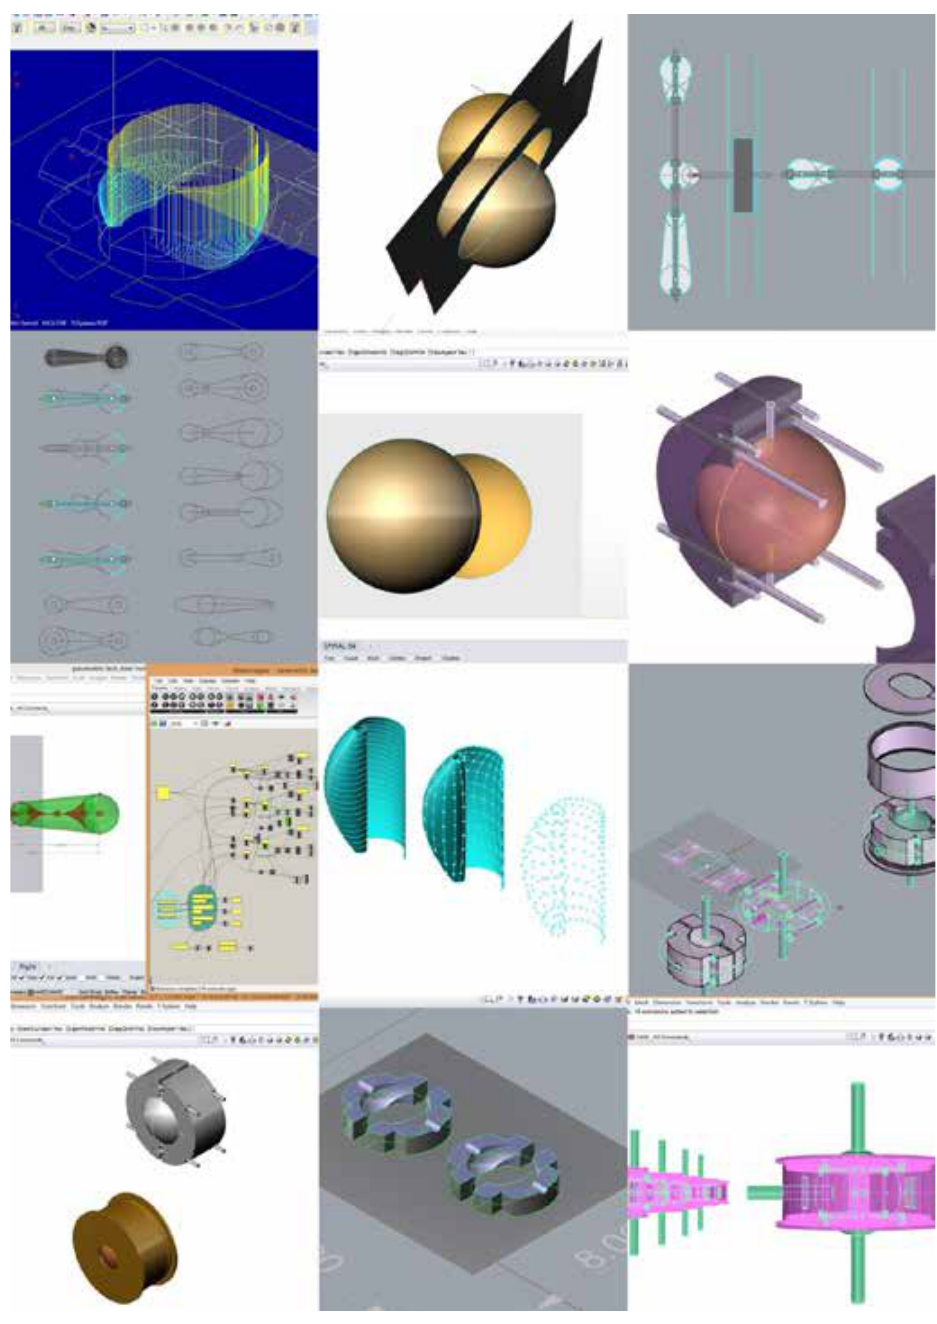
Figure 5: A moment without gravity for the sake of clarity. Numerous investigations progressed from physical material into digital development, often for increased precision and translation for machine language. Some ideas were digitally shaped, and material translations proved more